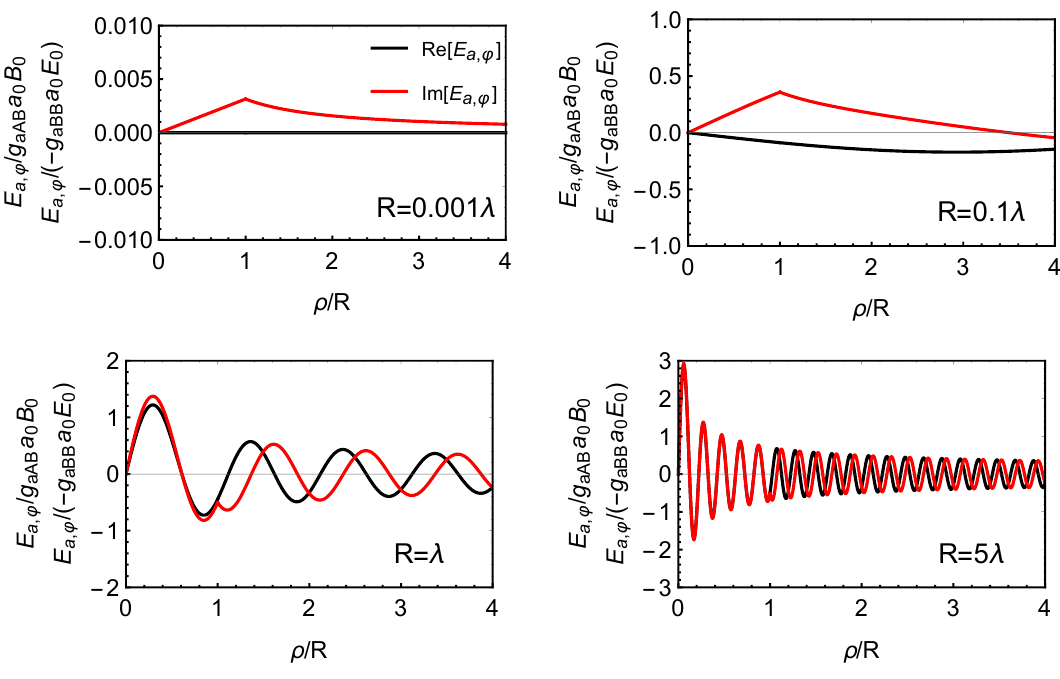
Figure 2 . Numerical results of axion-induced oscillating electric field ~E a,φ at t = 0 , in units of g aAB a 0 B 0 for case I or − g aBB a 0 E 0 for case II. We consider four kinds of relations between the detector scale R and axion Compton wavelength λ a : R = 0 . 001 λ a (top left), 0 . 1 λ a (top right), λ a (bottom left) and 5 λ a (bottom right), where λ a = 2 π/m a